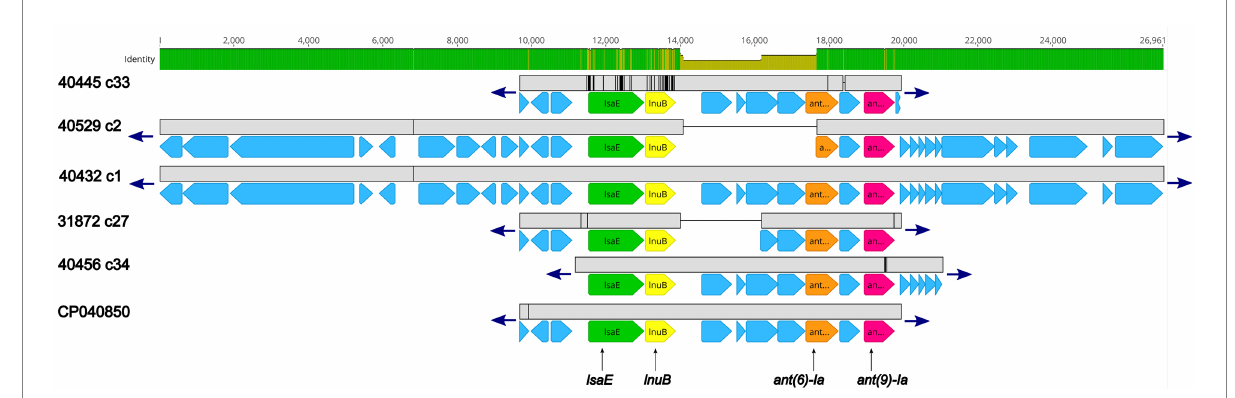
FIGURE 2 Genomic organization and alignment of the region containing the lsaE , lnuB, ant(6)-Ia, and ant(9)-Ia genes. The S. suis isolate and contig number (c) for each sequence, along with the accession number for the Enterococcus faecium plasmid shown at right. Base pair numbers are displayed above black bar at top. Green and yellow shaded bar below depicts sequence similarity with green indicating 100% identity and yellow indicating lower identity. Grey bar in between each aligned sequence region depicts sequence similarity between each sequence with grey indicating nucleotide positions with 100% identity. Blue arrows at end of grey bars indicate contig sequence continues. AMR gene elements are listed below and indicated by green ( lsaE ), yellow ( lnuB ), orange ( ant(6)-Ia ), and pink ( ant(9)-Ia ) genes. All other CDSs are indicated by light blue. The ant(6)-Ia gene in 40529 c2 is a partial gene (missing N-terminus) and is flagged as predicted pseudogene by PGAP. Accession number CP040850 is a complete nucleotide sequence from an Enterococcus faecium strain F17E0263 plasmid (p_unnamed1) isolated from a